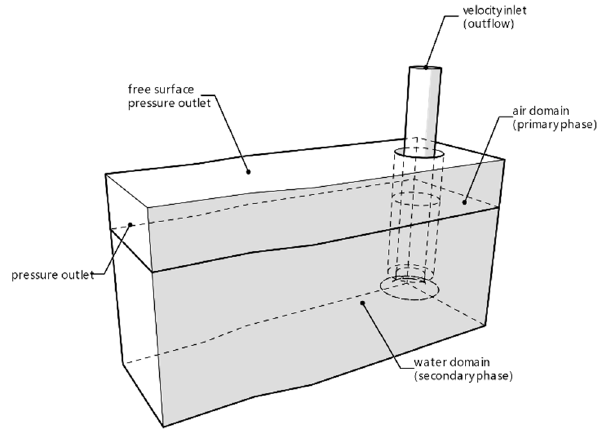
Figure 3. Overview of the boundary conditions and fluid domains for the numerical analysis.